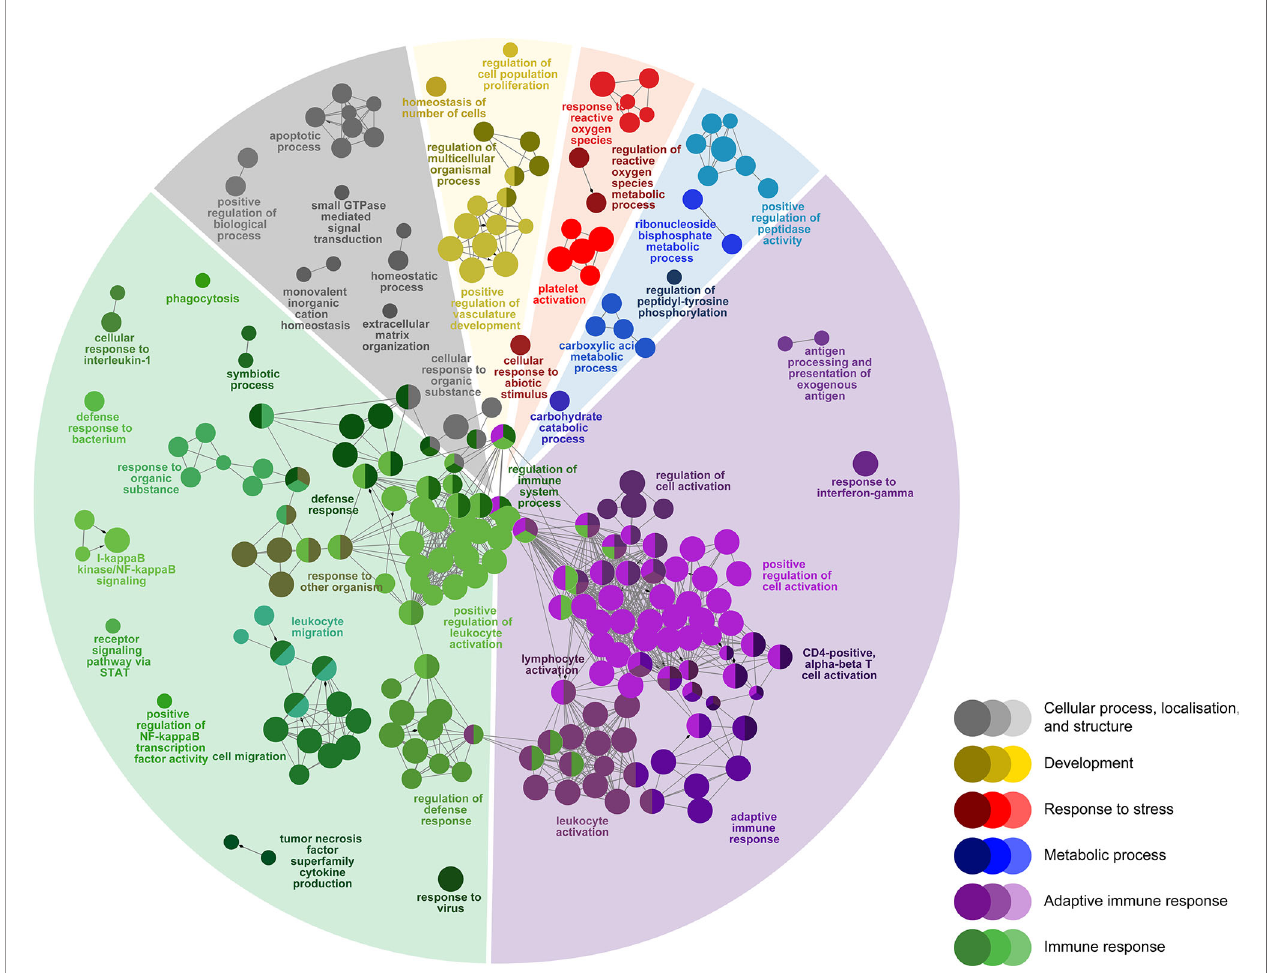
FIGURE 4 | Enriched biological processes GO term networks of SRS-responsive probes (n = 1470) in the head kidney of Atlantic salmon at 21 days post-injection (DPI) shared by both H-SRS and L-SRS groups. Nodes represent signi fi cantly enriched GO terms [right-sided hypergeometric test, p-values (p < 0.01) corrected by Benjamini-Hochberg]. GO terms are grouped by functional theme and arranged to fi t the sectors of a pie chart representing the proportion of GO terms in each functional theme. Nodes are colored according to the functional theme to which they were assigned. Grey lines in between GO terms indicate high connectivity (kappa coef fi cient > 0.5). Lines with arrows indicate the direction of positive regulation between GO terms, and lines with diamonds indicate the direction of regulation between GO